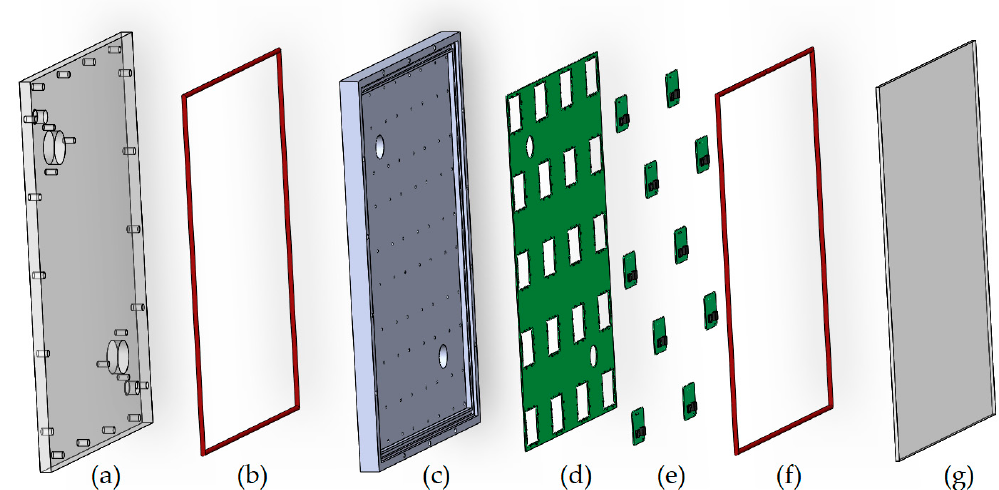
Figure 5. Designed layout of the array. ( a ) Plexiglas back cover. ( b ) Backside sealing. ( c ) Aluminum plate. ( d ) printed circuit board (PCB) for electrical connections. ( e ) Electronic drivers and LEDs. ( f ) Front side sealing. ( g ) Front glass cover.